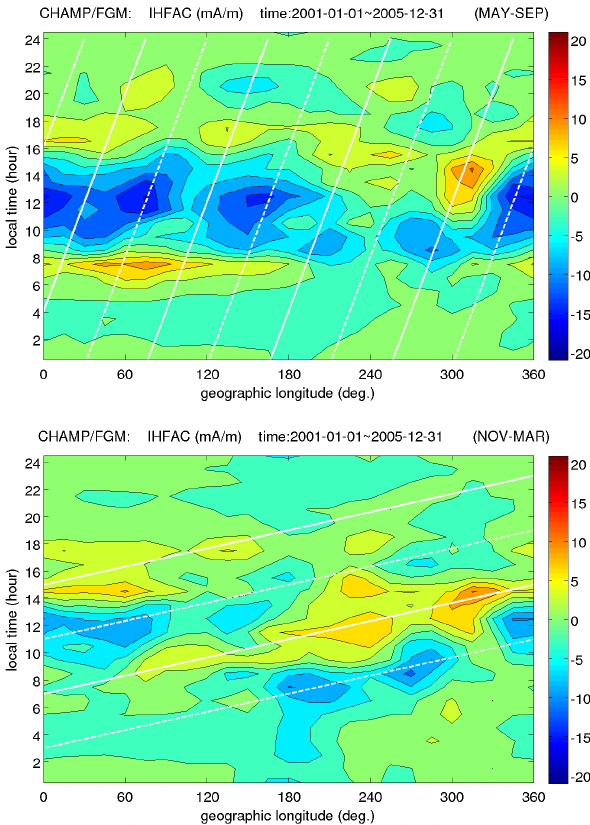
Fig. 5. IHFAC amplitudes are shown as a function of LT and GLON. The upper (lower) panel corresponds to May–September and November–March in 2001–2005, respectively. The contour lines are drawn for each 3mAm − 1